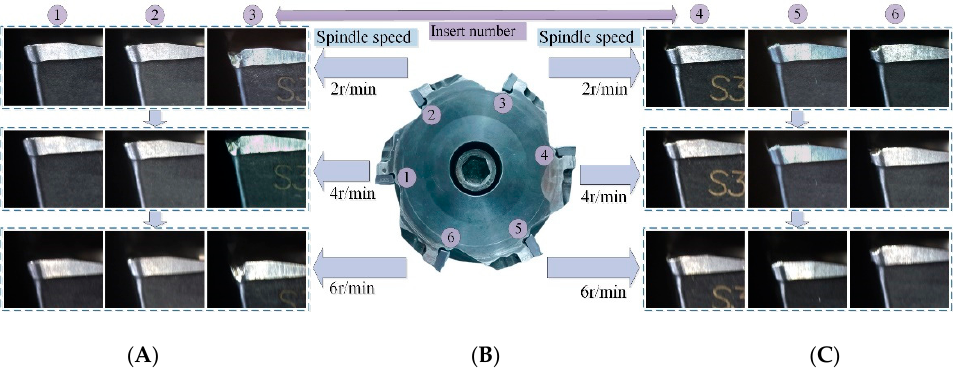
Figure 2. Experimental environment for milling and tool wear detection. ( A , C ) Actual detection images; ( B ) The overall image of camera bracket.